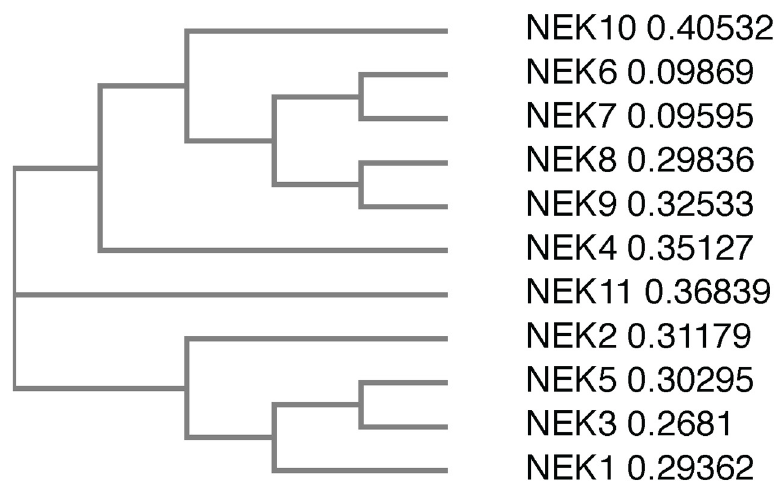
Figure 1. Phylogenetic tree of the full-length human Nek proteins. All full-length protein sequences were obtained from UniProtKB. Protein sequences were subsequently submitted to Clustal Omega, which generated a phylogenetic tree. The numbers next to the protein names refer to the sequence distance measure.